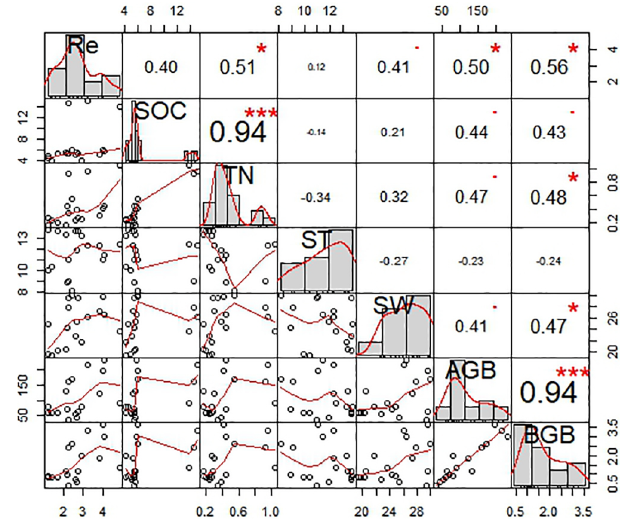
Figure 9. The correlation coefficient charts between ecosystem res- piration (Re) and biotic and abiotic factors for all six land surface types. The diagonal line in the figure shows the distributions of the variables themselves. The red line means the frequency distri- bution of variables. The lower triangle (left bottom) in the figure shows scatter plots of the two properties. The upper triangle (up- per right) in the figure indicates the correlation values of the two parameters; the asterisk indicates the degree of significance ( ∗∗∗ in- dicates significant differences at P < 0 . 001, ∗∗ indicates significant differences at P < 0 . 01 and ∗ indicates significant differences at P < 0 . 05). The bold bigger numbers mean the higher